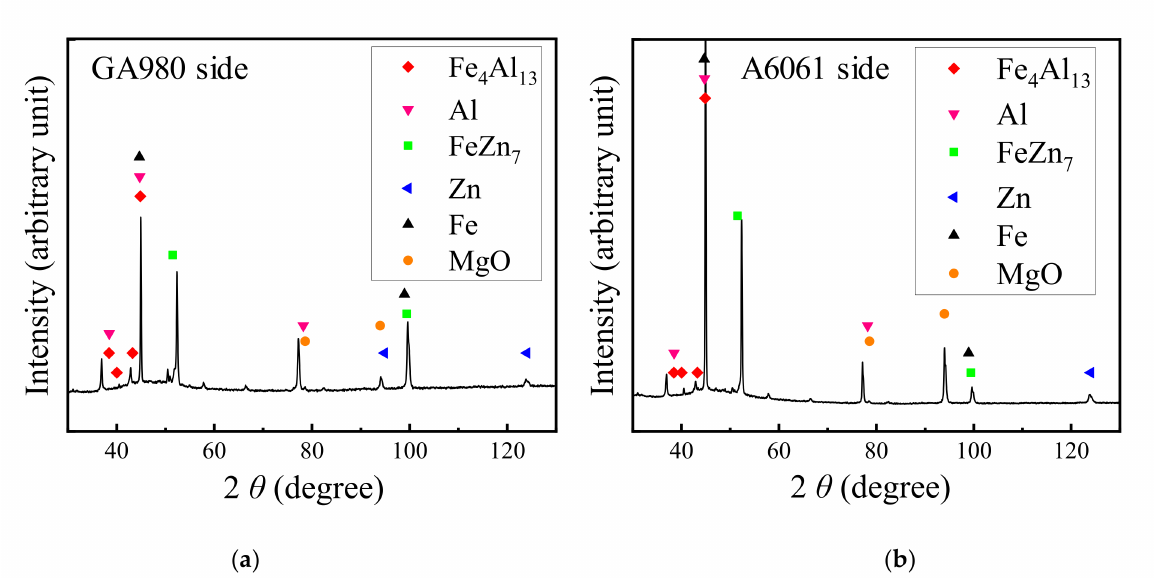
Figure 8. XRD analysis results for fracture surfaces ruptured by interfacial fracture in the tensile shear test with a joint welded at a welding time of 10 s. ( a ) Fracture surface of the GA980 sheet side and ( b ) fracture surface of the A6061 sheet